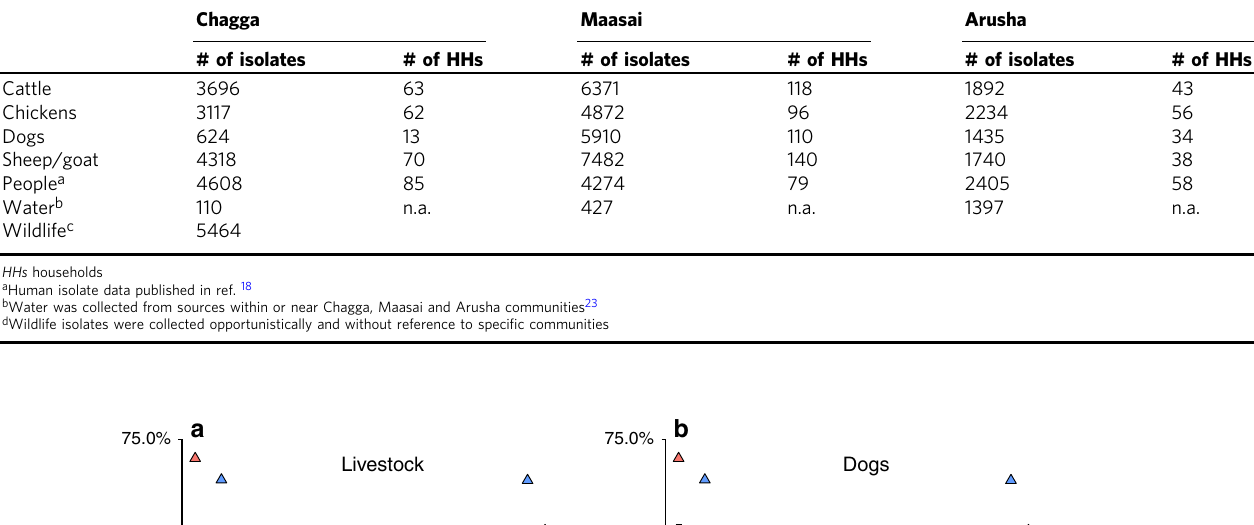
Table 2 Number of households and isolates from animals, water, and wildlife. Chagga